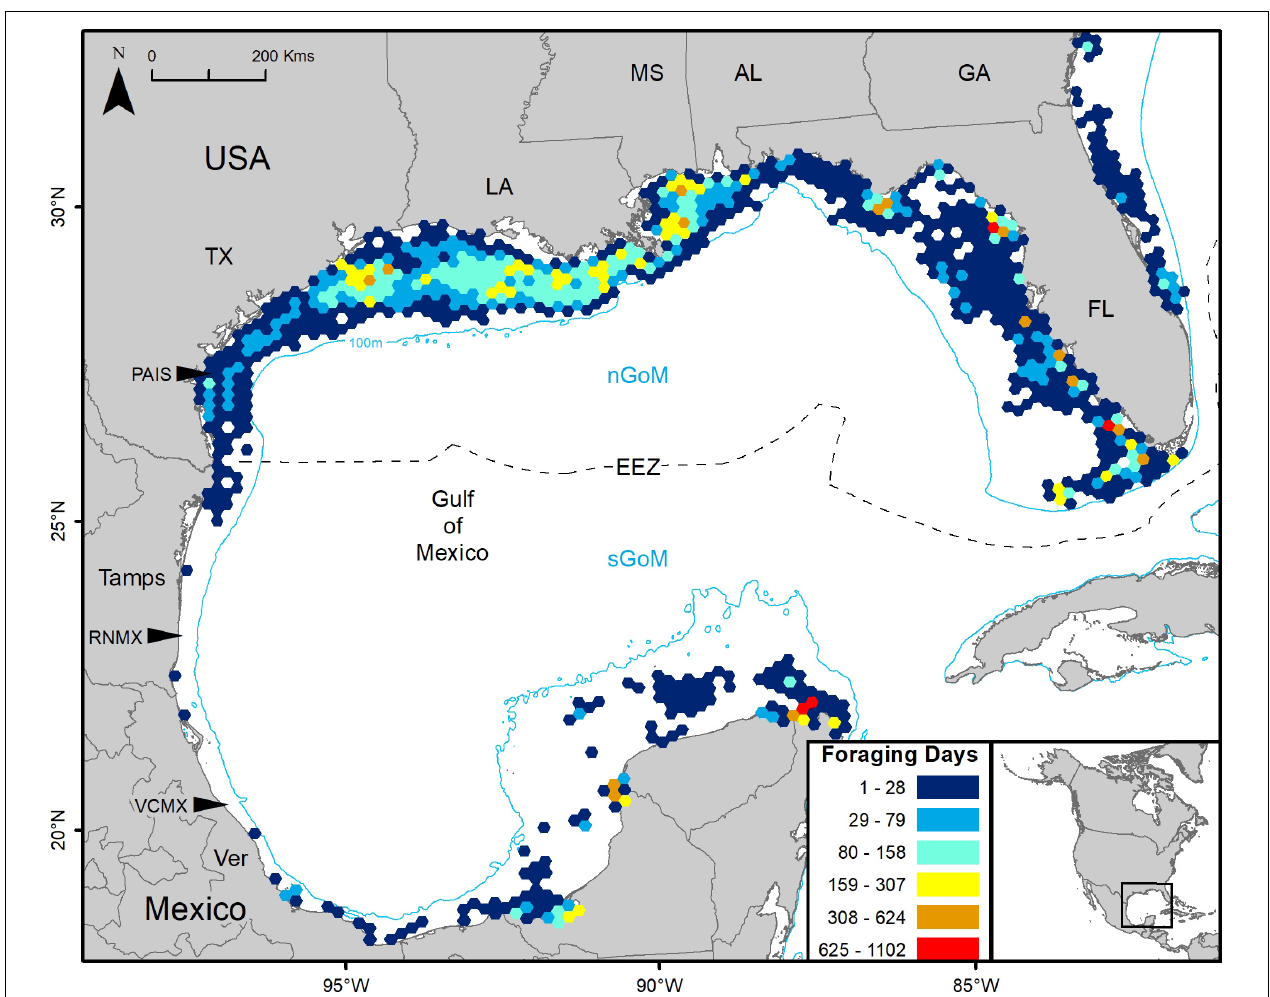
FIGURE 2 | Switching state-space model-derived foraging days for 117 post-nesting female Kemp’s ridley sea turtles tracked from the primary and major secondary nesting beaches summarized in 25 km hex-bin cells: Padre Island National Seashore, Texas, United States (PAIS); Rancho Nuevo, Tamaulipas (Tamps), Mexico (RNMX); Tecolutla, Veracruz (Ver), Mexico (VCMX). The Exclusive Economic Zone (EEZ) demarcates the division between the northern Gulf of Mexico (nGoM) and southern Gulf of Mexico (sGoM). Transmitters were deployed between 2010 and